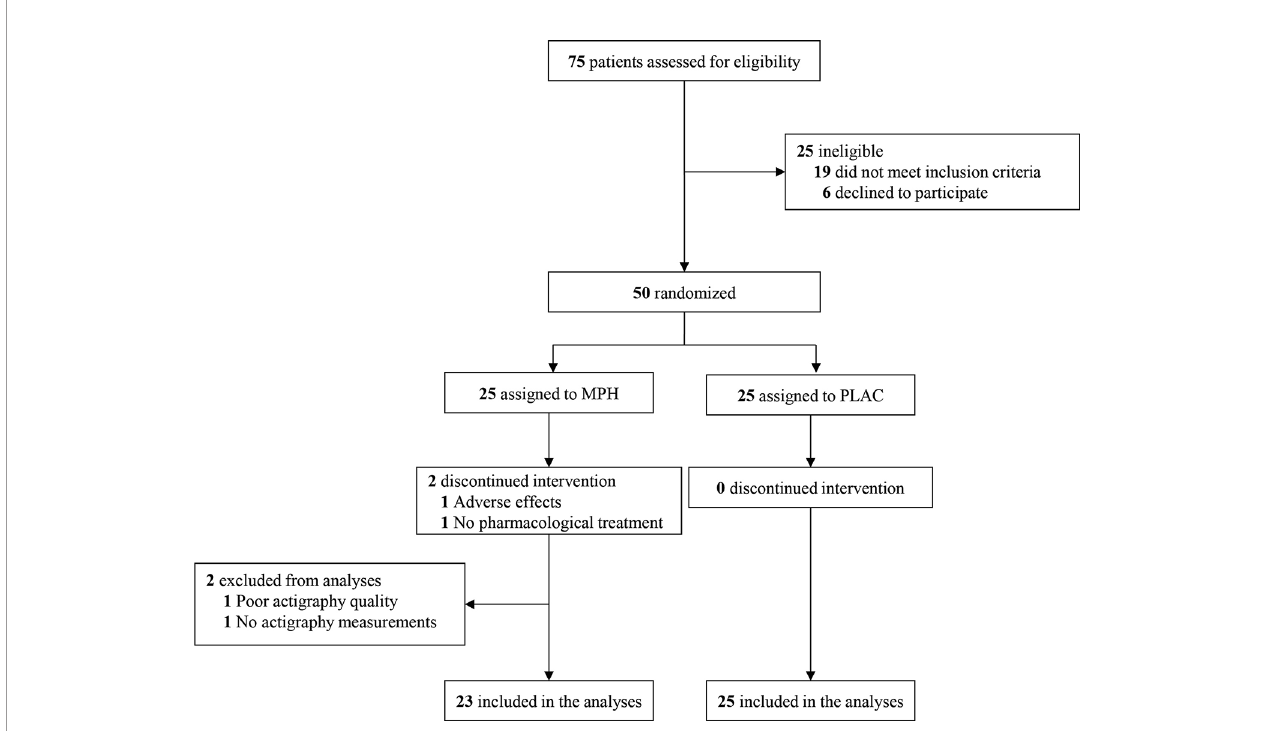
FIGURE 2 | Consolidated standards of reporting trials fl ow diagram. MPH, methylphenidate condition; PLAC, placebo